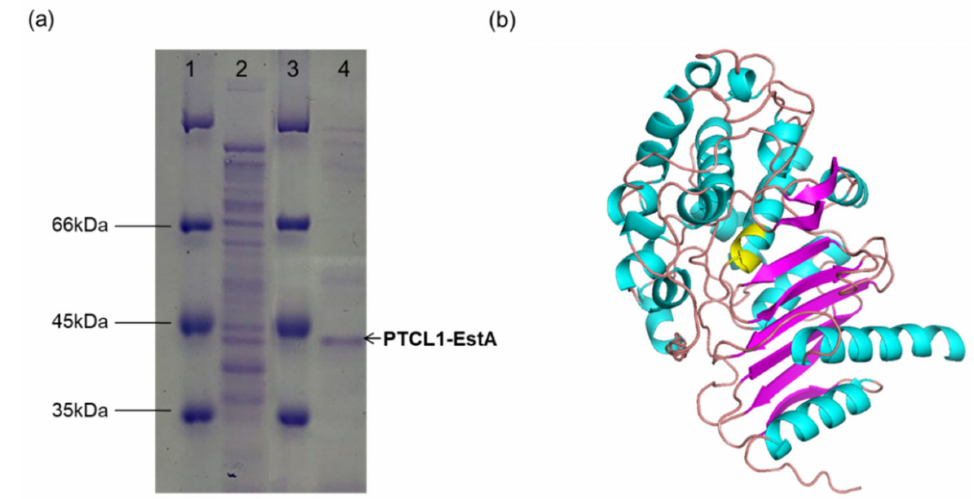
Figure 2. ( a ) SDS–PAGE image of purified PTCL1-EstA expressed in E. coli . Lanes 1 and 3: protein marker; lane 2: crude enzyme solution; lane 4: purified PTCL1-EstA. ( b ) The homology structural model of PTCL1-EstA. The residues in yellow indicate the putative active